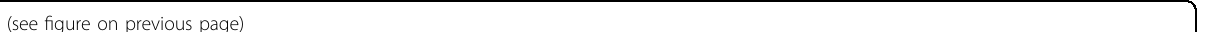
Fig. 6 ACE2 surface translocation upon ex vivo R848 stimulation is positively associated with hyperactivation responses and PD-L1 expression in blood myeloid cells from COVID-19 patients. a Mass cytometry analysis of cell surface ACE2 expression in blood myeloid populations from untreated samples ( n = 7 HC; n = 7 severe COVID-19) and R848-treated samples ( n = 7 HC; n = 15 moderate COVID-19; and n = 16 severe COVID-19). b Violin plots of frequencies of the myeloid compartment expressing surface ACE2 as shown in a . c Frequencies of ACE2 + and ACE2 – cells (based on ACE2 surface expression) within the myeloid compartment expressing the indicated markers in cells from severe COVID-19 patients. d Graphic summary of SARS-CoV-2 infection in monocytes co-expressing surface ACE2 and TMPRSS2 upon TLR4/7/8 activation. ACE2 is taken up by monocytes from ACE2-containing exosomes and stored in the early endosome at steady state. TLR7/8 activation triggered by endocytosis of SARS-CoV-2 or TLR4 activation triggered by viral proteins or host-derived danger signals released during infection stimulates downstream TLR signaling pathways to enhance gene expression of TMPRSS2, proin fl ammatory cytokines, IL-10, and PD-L1, which drive the cytokine storm and promote immune suppression. TLR4/7/8 activation also induces ACE2 translocation through endosomal traf fi cking to the cell membrane. Translocated ACE2 and newly synthesized TMPRSS2 at the cell surface facilitate SARS-CoV-2 viral entry and active replication in monocytes. Image generated with